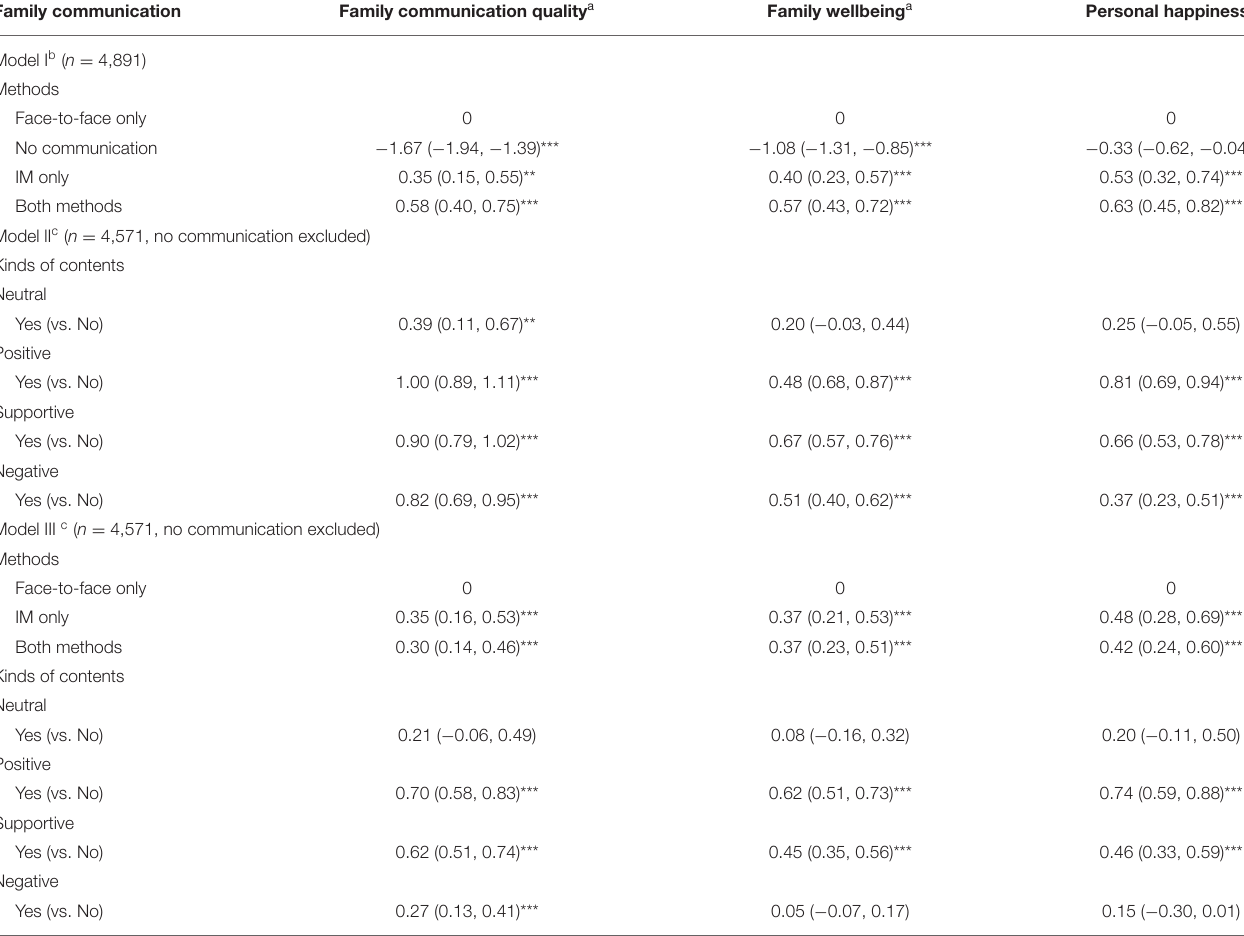
TABLE 3 | Associations of communication methods with outcomes, adjusted β (95% CIs) ( n = 4,891). Family